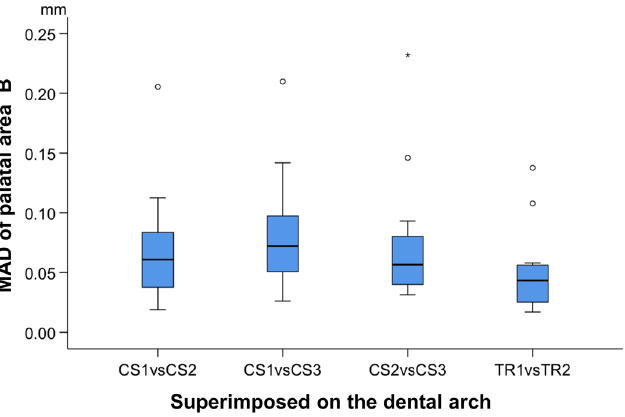
Figure 3. Box plots showing the precision of the two scanners (CS3600 and TRIOS3) measured through the MAD of palatal area B, between repeated scans superimposed on the dental arch (mm; Friedman test, p = 0.176). The upper limit of the black line represents the maximum value, the lower limit the minimum value, the box the interquartile range, and the horizontal line the median value. Outliers are shown as circles or stars, in more extreme cases. CS1, CS2, CS3: CS3600 repeated scans. TR1, TR2: TRIOS3 repeated